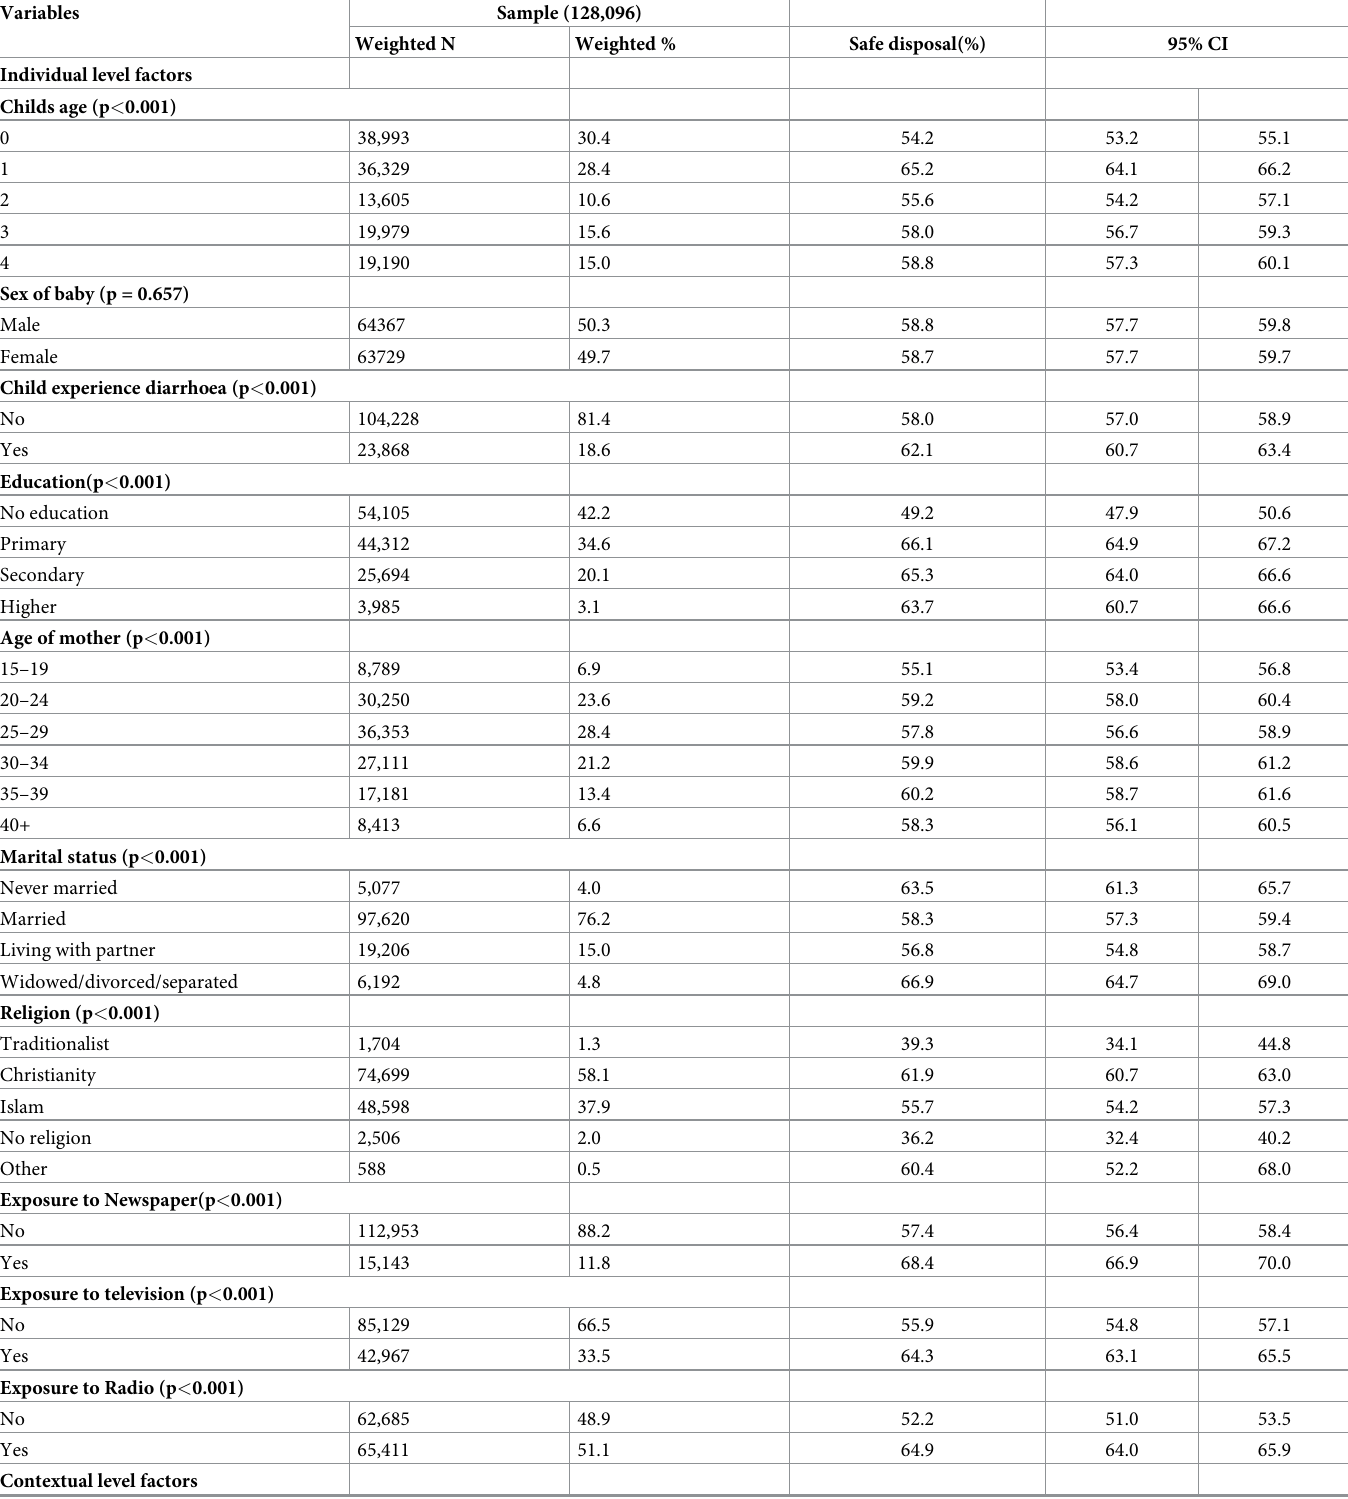
Table 2. Prevalence of safe children’s stool disposal across independent variables among women in SSA. Variables Sample (128,096) Weighted N Weighted % Safe disposal(%) 95% CI Individual level factors Childs age (p <